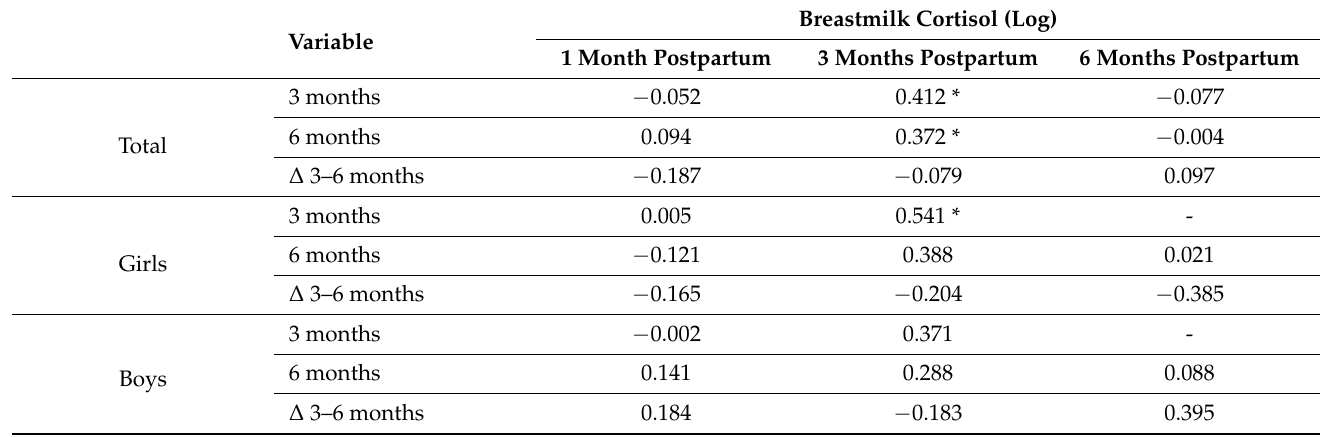
Table 5. Partial correlations between breastmilk cortisol(log) and infant BMI z-score at the 3rd and 6th months adjusted for the season of breastmilk collection and breastmilk energy value and crude protein.